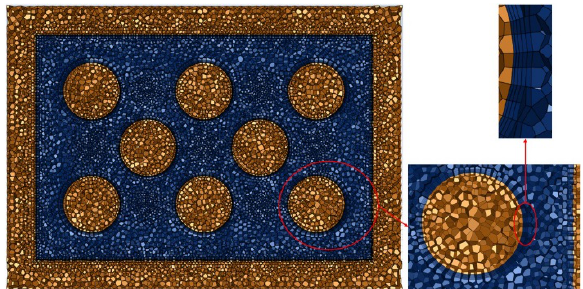
Figure 4. Polyhedral grid generation in the lower microchannel layer.